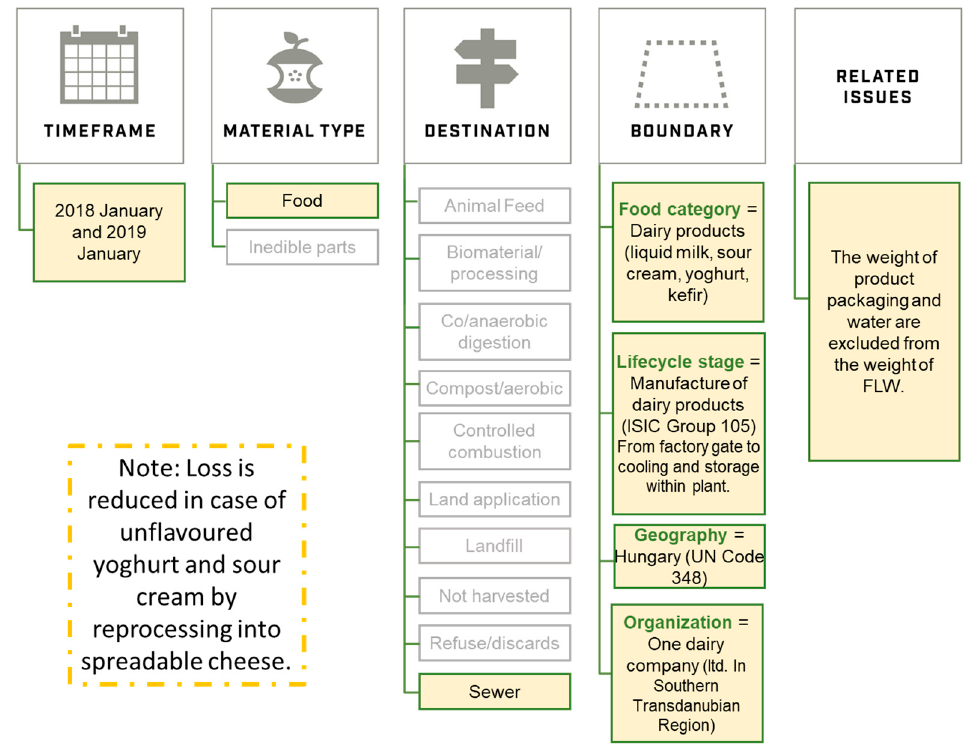
Figure 2. The investigated company’s framework of loss based on the FLW standard.